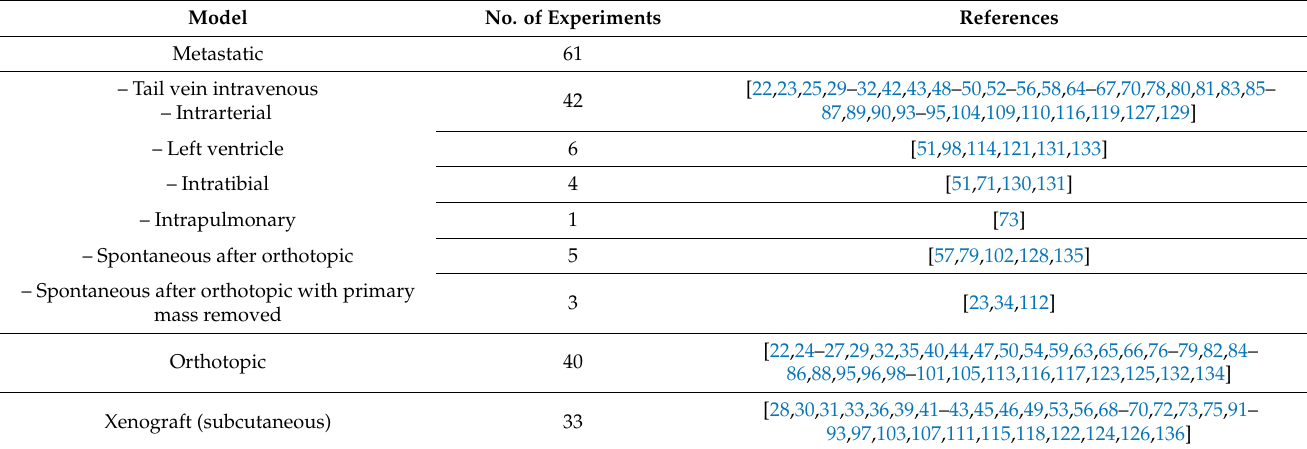
Table 3. Murine models used in miRNA